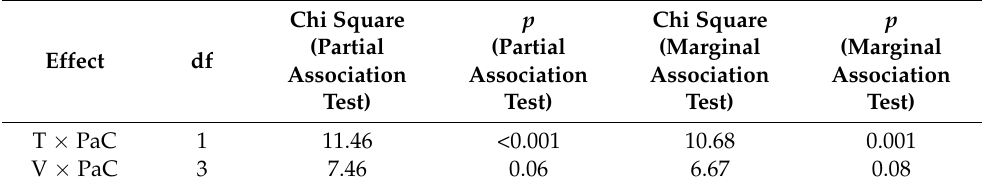
Table 4. Log linear results showing the effect of each factor (T = treatment; V = vineyard) on colony parasitization rate (PaC = parasitization rate on colonies).